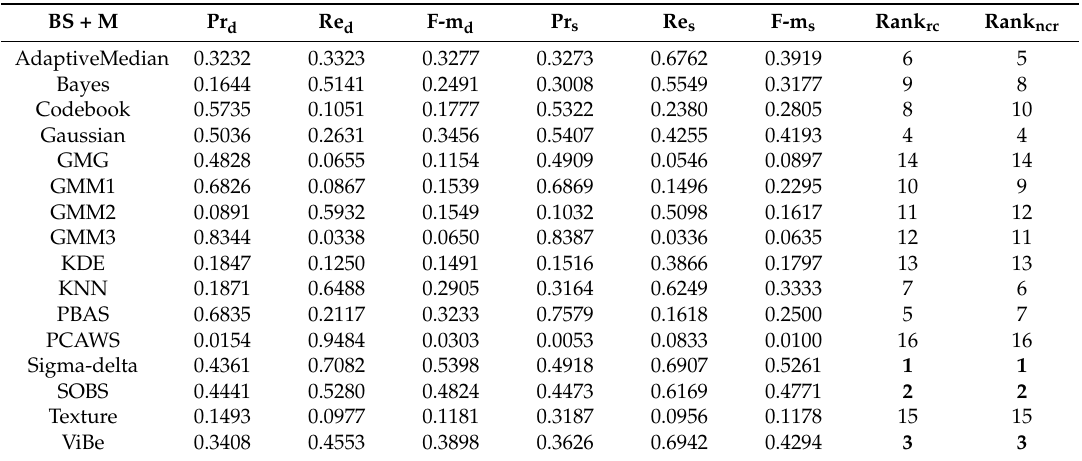
Table 12. Evaluation metrics and ranks of the evaluated BS with median filter.